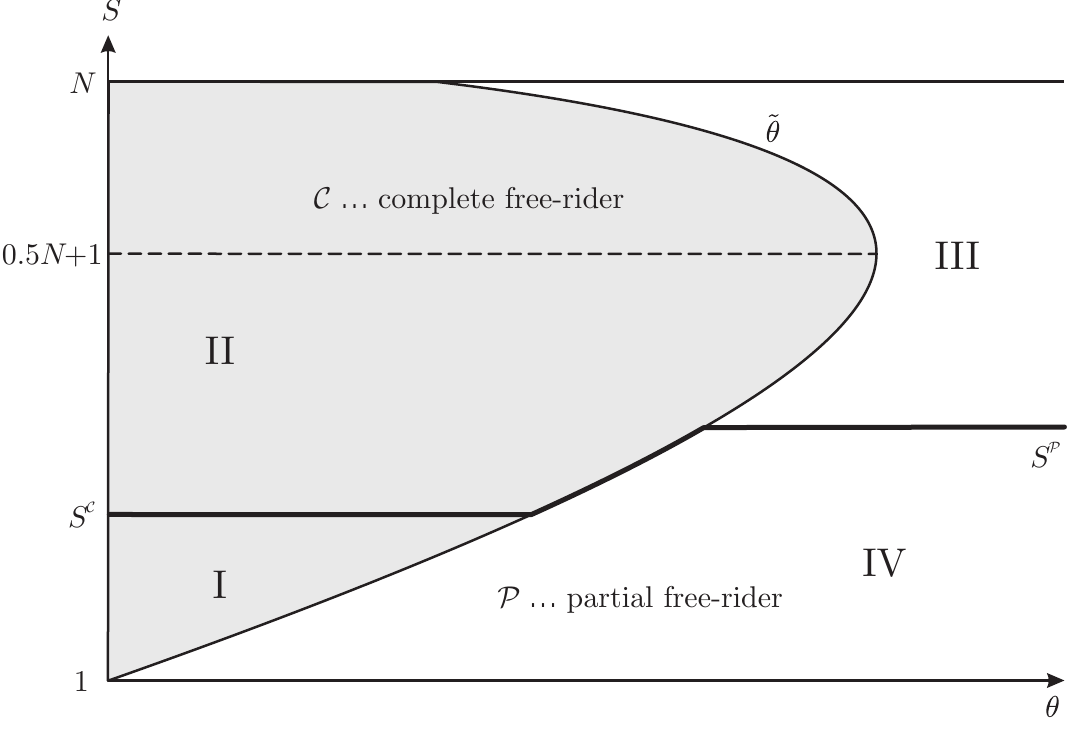
Figure 2. Free-riding and cost